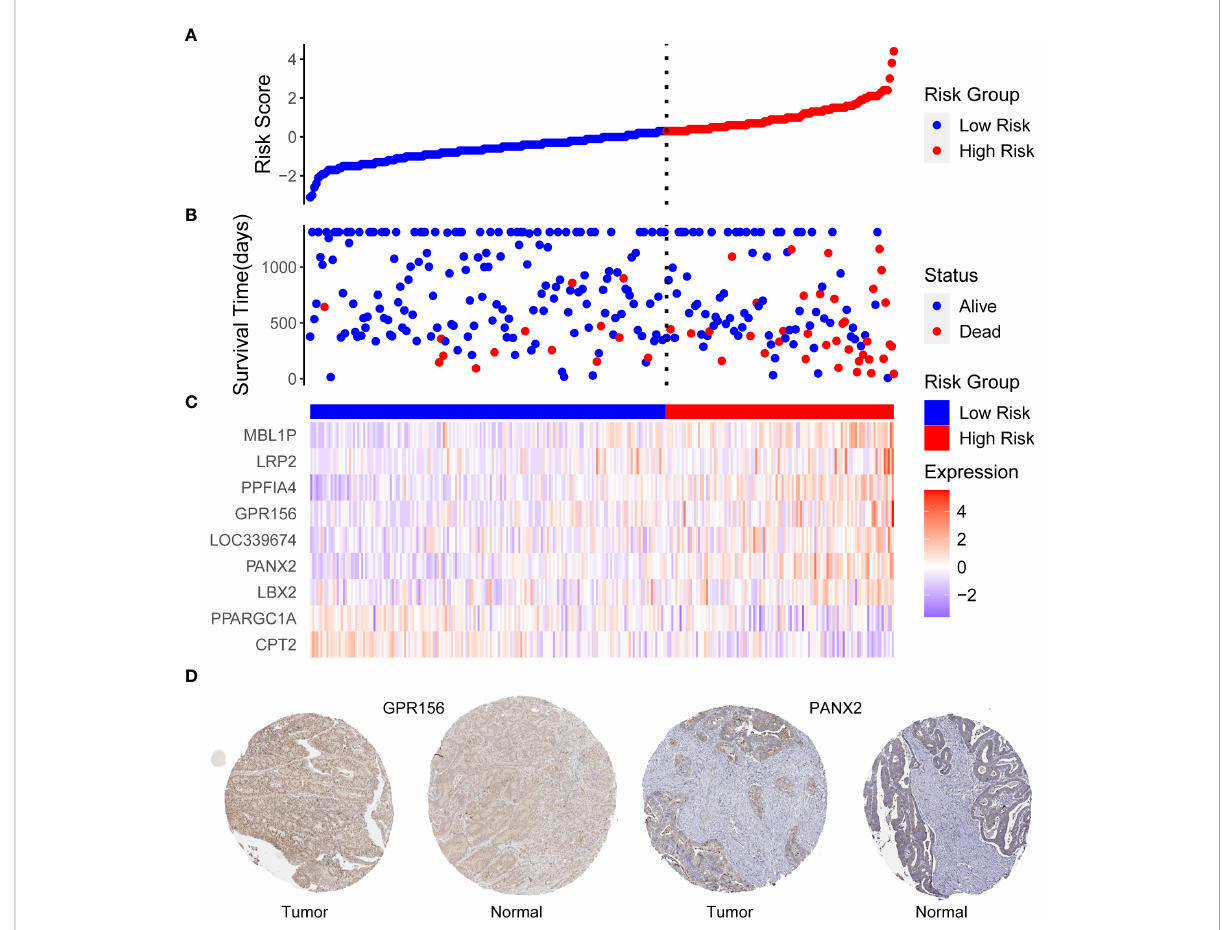
FIGURE 3 (A) Distribution of risk scores, (B) patient survival status, and (C) heat map expression differences of 9-DEGs in TCGA training dataset. The horizontal coordinates are patient IDs ranked by risk score from smallest to largest. The vertical coordinates are risk score, survival time (days), and nine candidate genes, (D) Expression of GPR156 and PANX2 in tumor and normal tissues. Based on an analysis of immunohistochemically staining data from the Human Protein Atlas database, the expression of GPR156 and PANX2 in tumor was compared with that in normal